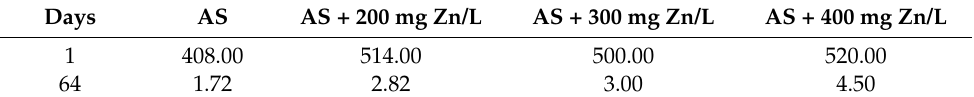
Table 2. Sulfate concentrations on days 1 and 64 in the activated sludge (AS) at increasing feed zinc concentrations.